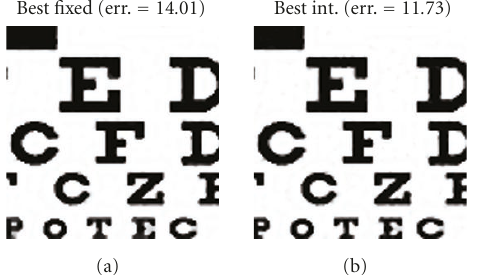
Figure 9: Synthetic dataset results. (a) The best (minimum MSE) image from the fixed-registration algorithm, having super resolved the dataset multiple times with di ff erent prior strength settings. (b) The best result using our approach of integrating over θ and λ . As well as having a lower RMSE, note the improvement in black-white edge detail on some of the letters on the bottom line.